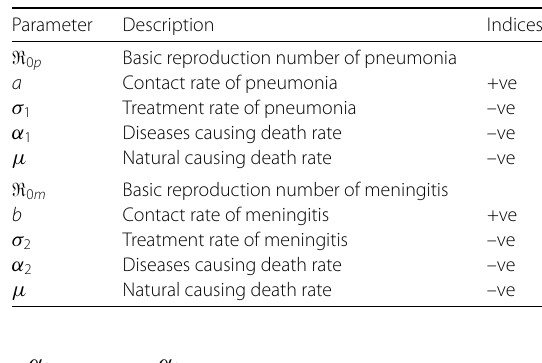
Table 1 Indices of sensitivity Parameter Description Indices (cid:4) 0 p Basic reproduction number of pneumonia a Contact rate of pneumonia +ve σ 1 Treatment rate of pneumonia –ve α 1 Diseases causing death rate –ve μ Natural causing death rate